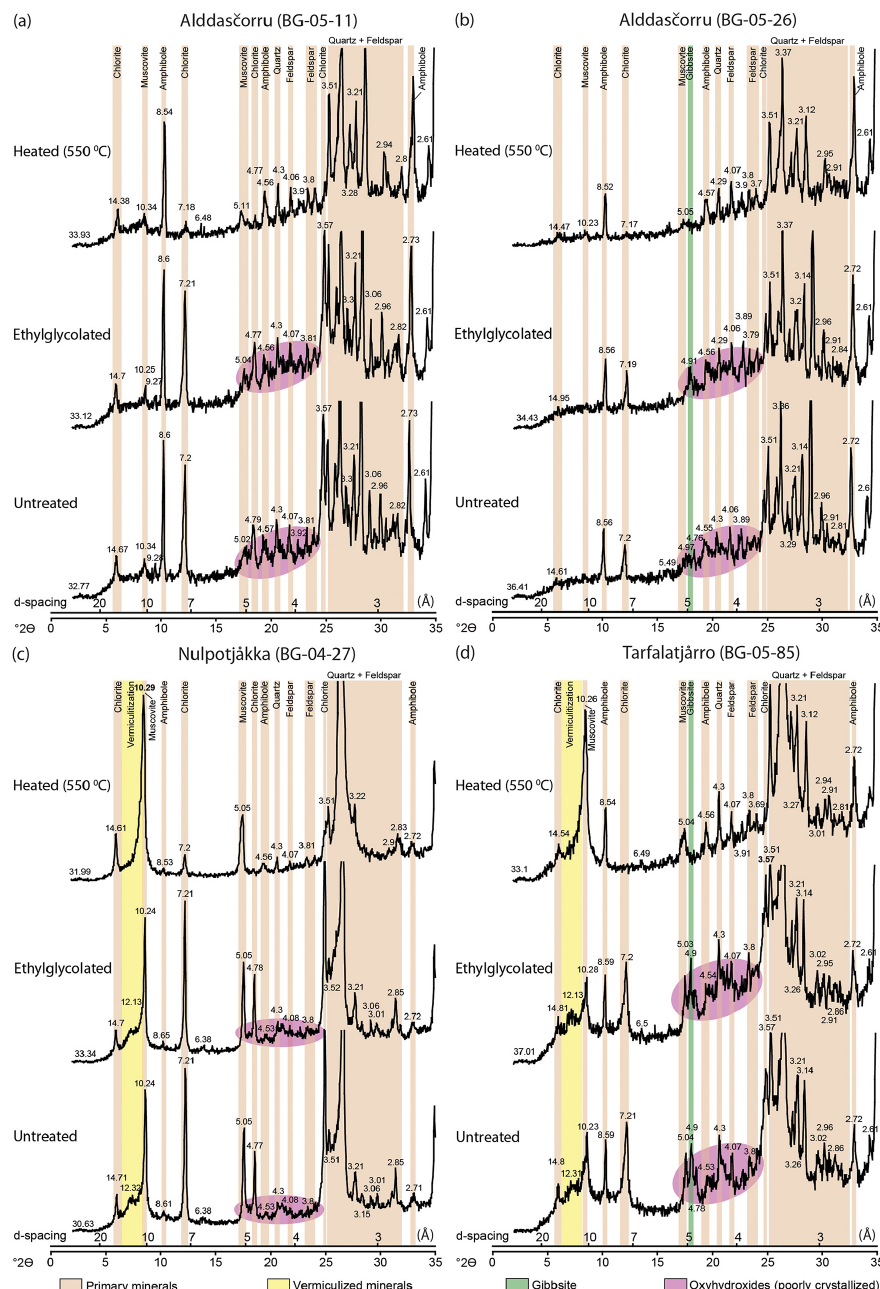
Figure 5. Four representative X-ray diffractograms of the clay-sized fraction ( < 2µm) of fine matrix samples from (a) Alddasˇcorru, (b) Ald- dasˇcorru, (c) Nulpotjåkka, and (d) Tarfalatjårro. For each sample three diffractograms are shown. In the bottom diffractograms the samples are untreated, in the middle diffractograms the samples are ethylglycolated, and in the top diffractograms the samples are heated to 550 ◦ C. These diffractograms illustrate the range of minerals present (labelled) in the Alddasˇcorru, Duopteˇcohkka, and Tarfalatjårro blockfields, and in the till samples. Poorly crystallized oxyhydroxides produce a rise in the diffractogram baseline, which disappears on heating, at d spacings between 5 and 3.5 Å (pink-filled circles). Vermiculization of chlorite and/or mica is shown by peaks in the ∼ 10–14 Å (yellow) area that collapse to 10 Å on heating. Gibbsite is shown by peaks at 4.9 Å (green), which also collapse on heating.